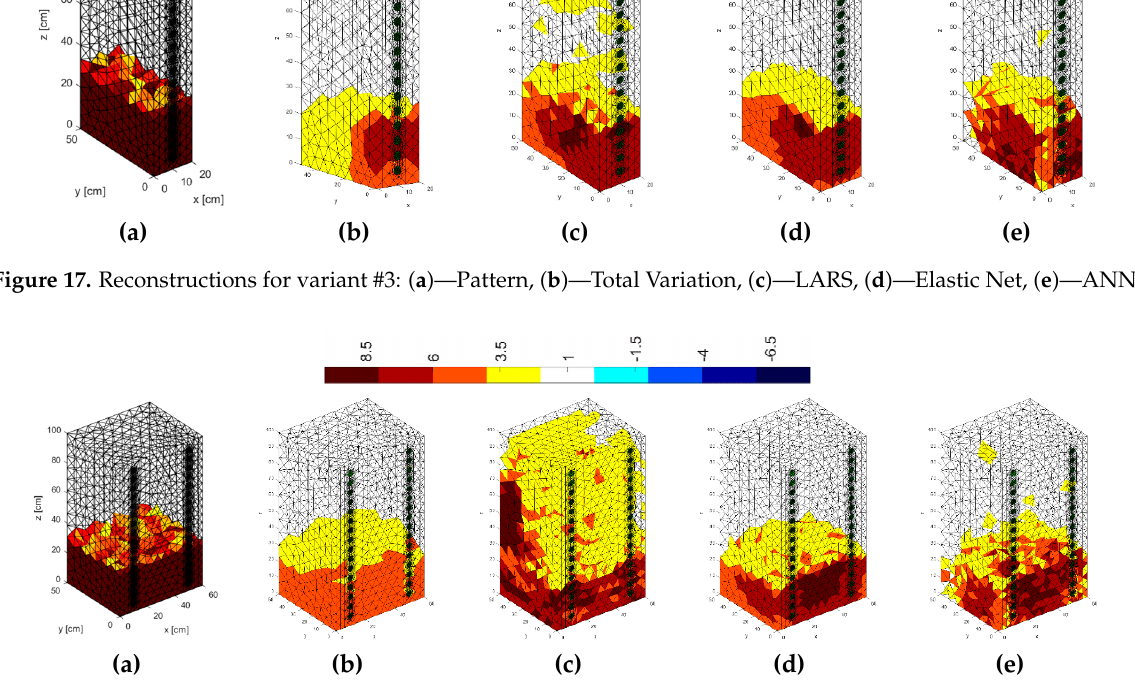
Figure 17. Reconstructions for variant #3: ( a )—Pattern, ( b )—Total Variation, ( c )—LARS, ( d )—Elastic Net, ( e )—ANN